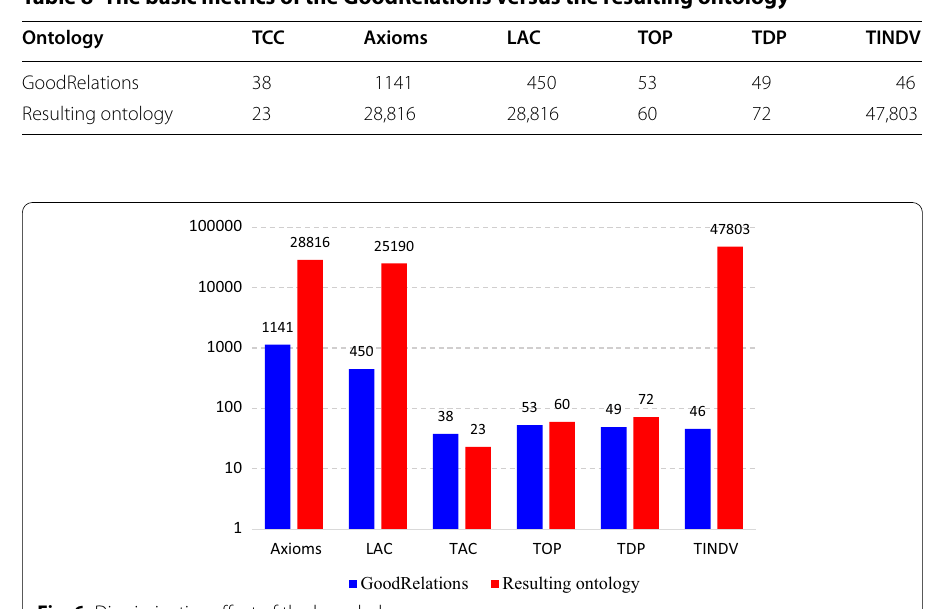
Fig. 6 Discriminative effect of the knowledge coverage